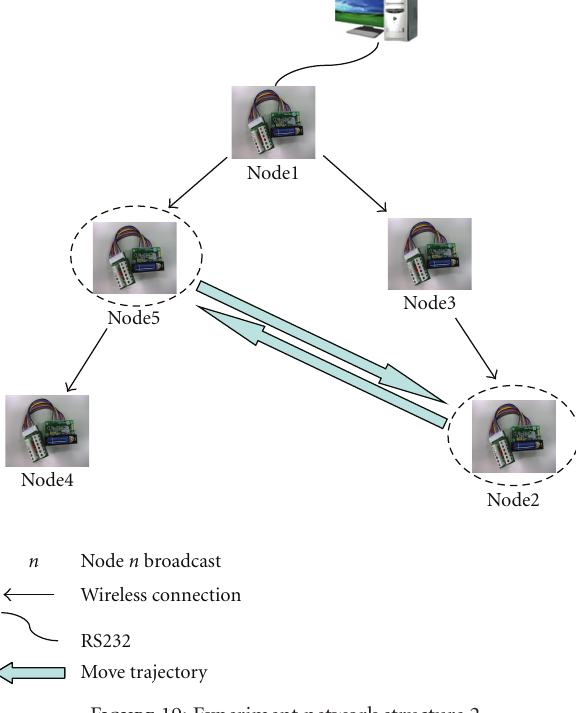
Figure 19: Experiment network structure 2.